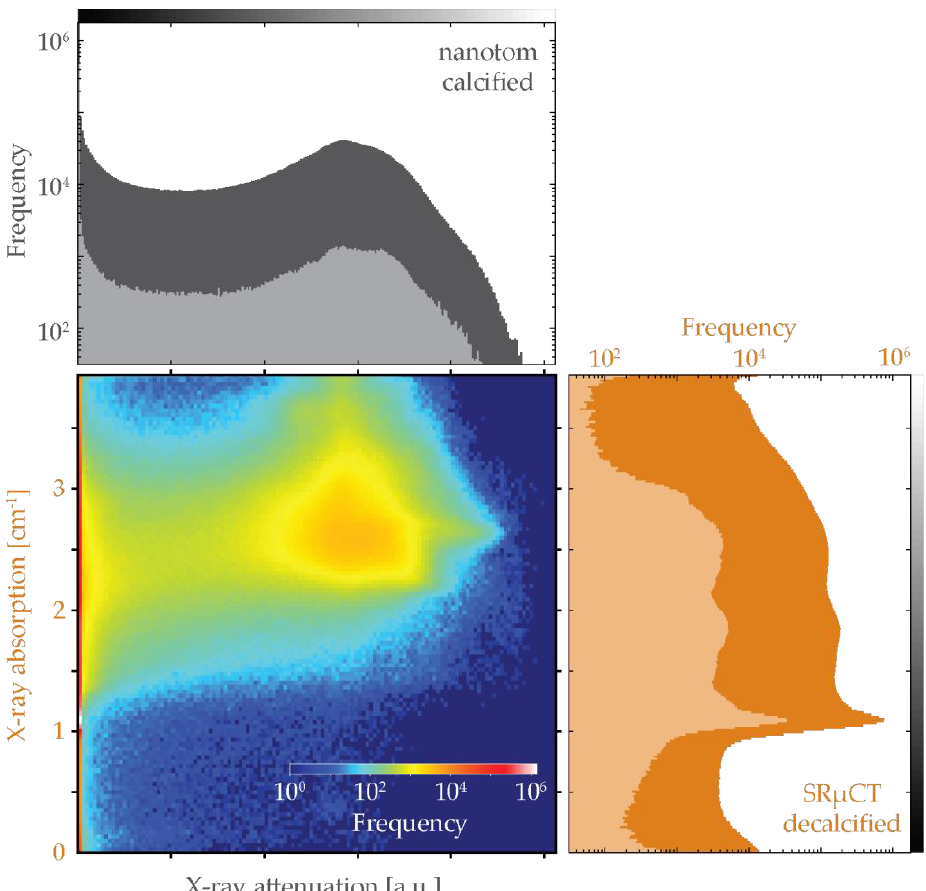
Figure 7. Bi-variate histogram of the common volume measured before decalcification using conventional µCT (nanotom m), and after decalcification using the synchrotron radiation facility (SRµCT). The projection of these logarithmically presented bi-variate data to the axes yield the univariate histograms of the individual tomographic datasets. Note that the soft tissues are almost transparent for the nanotom study, and hence the first bin reaches a value greater than 10 7 . The univariate histograms shown in lighter colors and with about two orders of magnitude lower frequencies capture the distribution of the virtual slice corresponding to the histological section, see below.